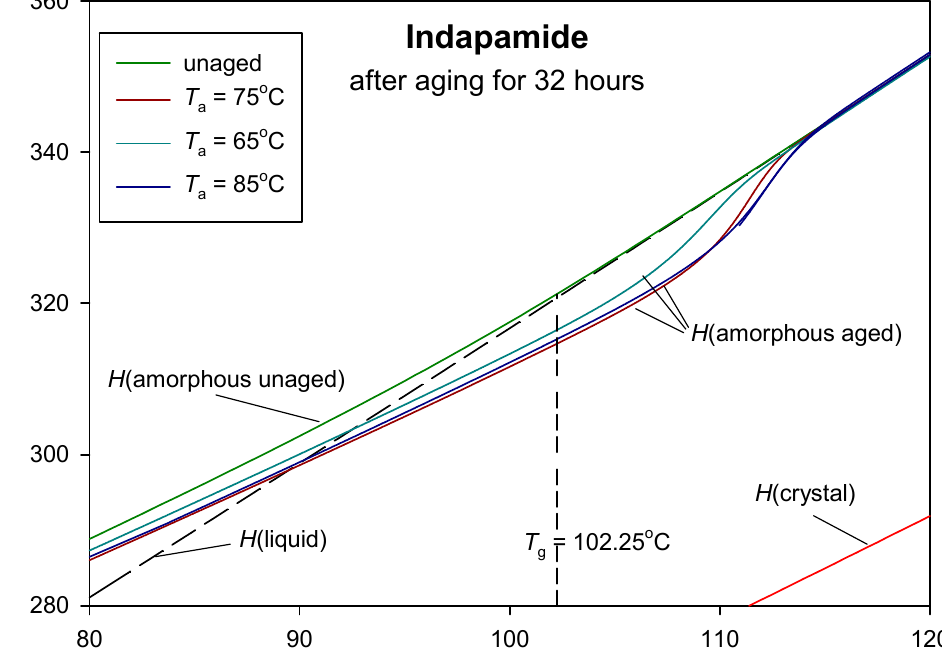
Figure 10. Changes of the total enthalpy vs. temperature for amorphous indapamide aged ( H (aged)) and unaged ( H (unaged)) in the glass transition region; dashed line is the extrapolation of the enthalpy of the liquid state ( H (liquid)), and H (crystal) is the total enthalpy of the crystalline IND sample.